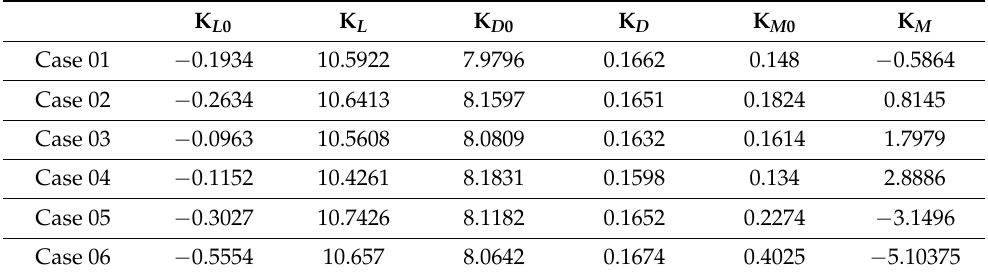
Table 2. Values of Ks for Case 01-Case 06.